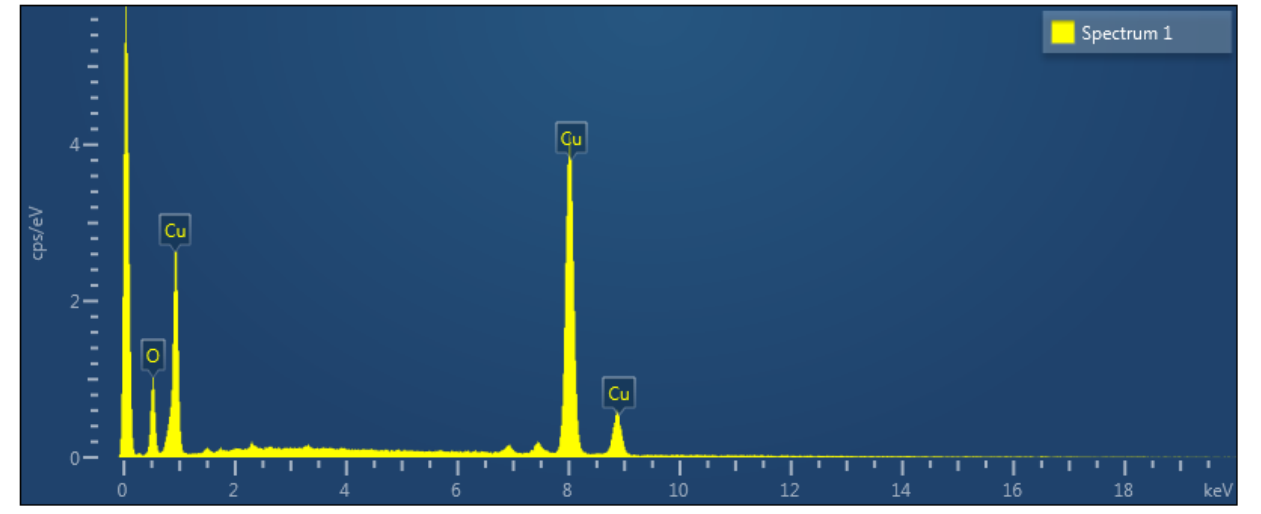
Figure 3. EDX spectrum of CuO NPs.